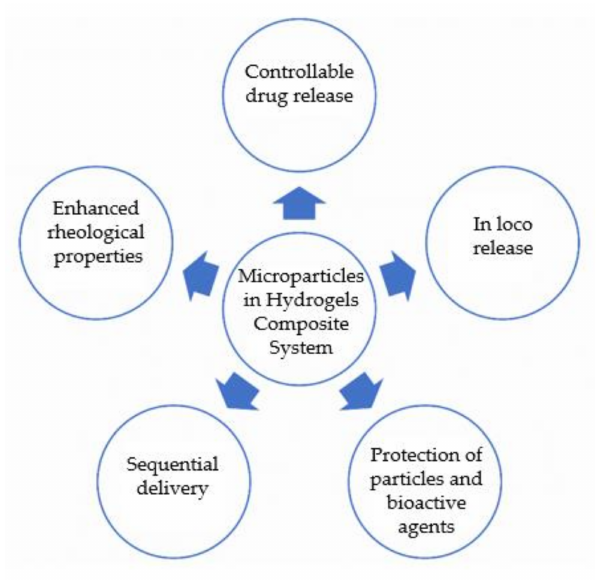
Figure 2. Advantages of microparticles in hydrogel systems for application as